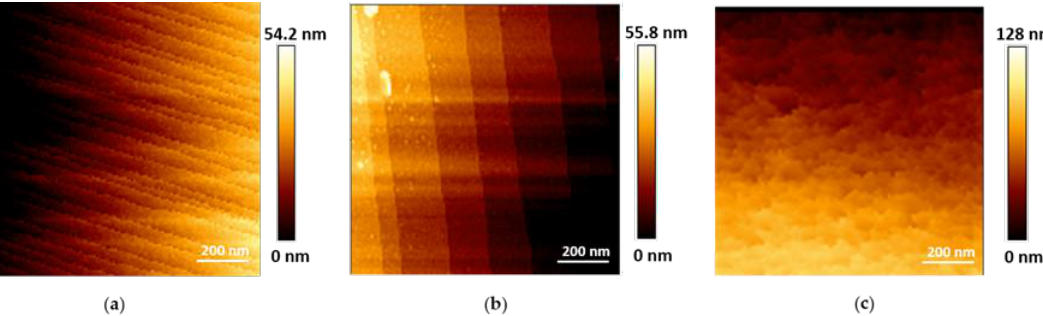
Figure 4. Topographic map of microMOFs (+) particles by in situ AFM (128 pixels × 128 pixels), in water ( a ), in PBS pH 5.4 ( b ) and in PBS pH 7.4 ( c ).